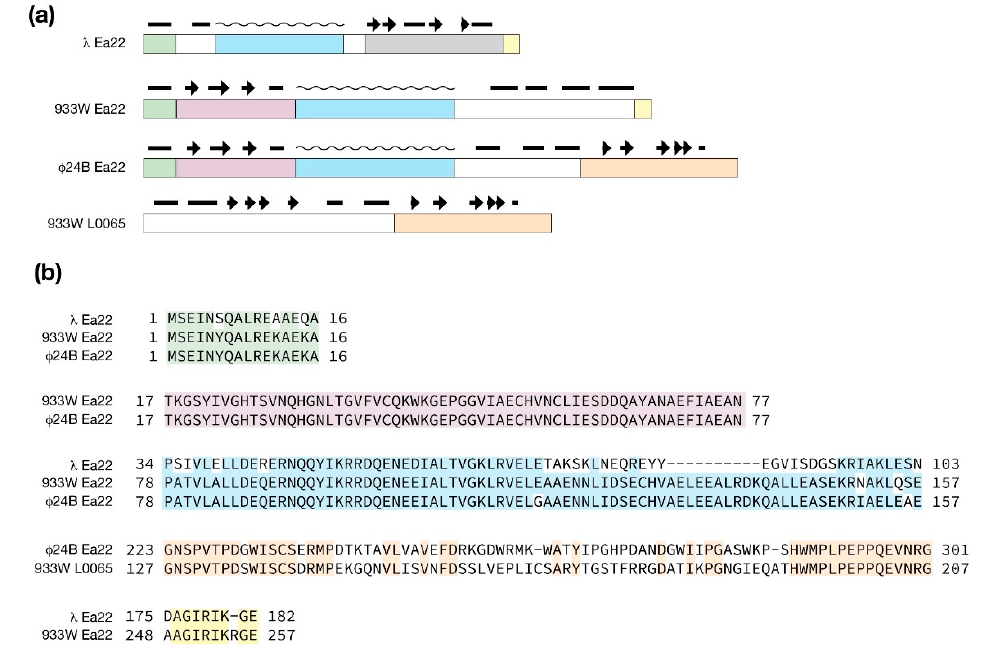
Figure 6. Ea22 proteins from λ and the Stx + phages Ф 24 B and 933W. ( a ) Blocks of similarity with predicted secondary structure above with helices (bars), strands (arrows) and coiled-coiled regions (wavy lines). ( b ) Sequence comparisons of the same blocks. The C-terminal sequence of λ Ea22 shaded grey cannot be aligned to the Ea22 sequences from Ф 24 B and 933W.